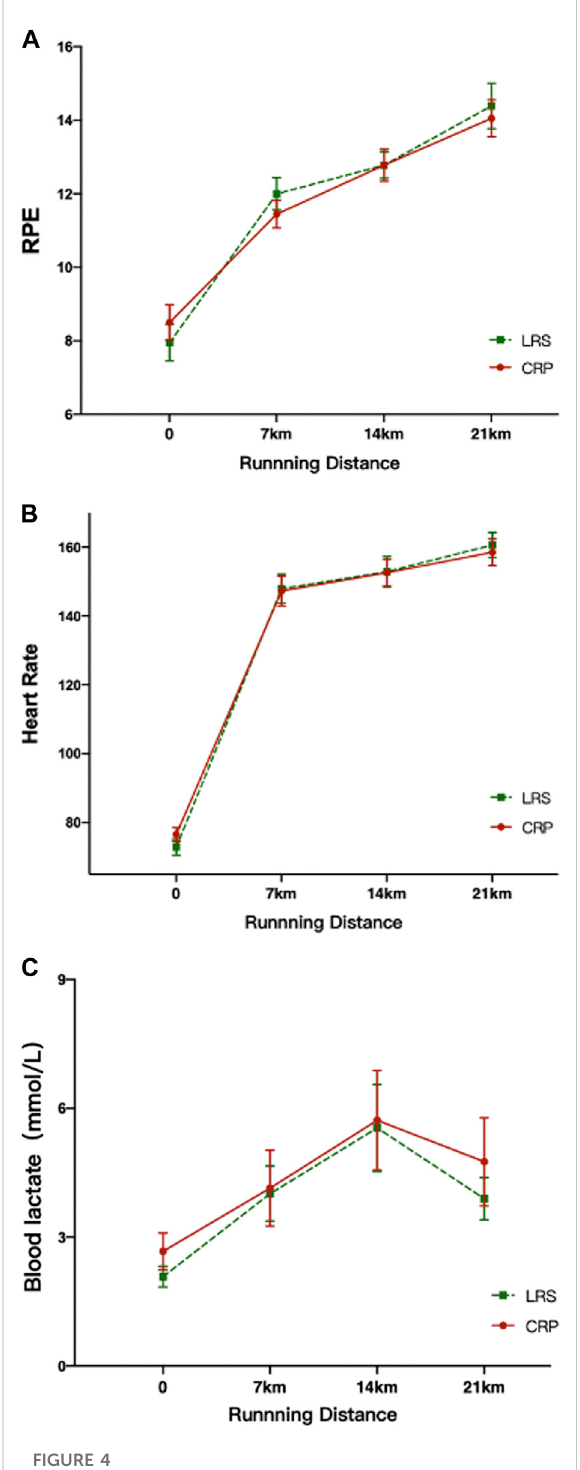
FIGURE 4 Heart rate, RPE and blood lactate at different running distances while wearing CRP and LRS. (A) RPE at different running distances; (B) Heart rate at different running distances; (C) blood lactate at different running distances. CRP, compression running pants; LRS, loose running shorts.